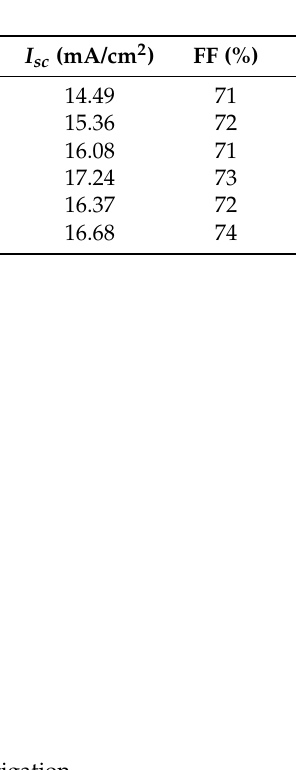
Figure 4. Cyclic voltammograms of specimens under investigation.